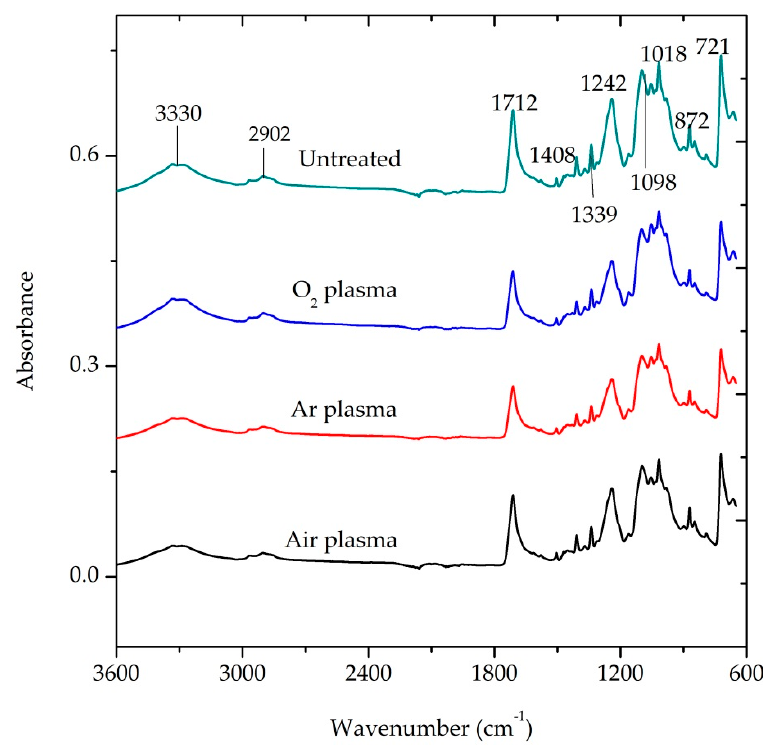
Figure 10. ATR-FTIR spectra of plasma treated and untreated P / C blend fabric (plasma condition: 0.3 mbar pressure, 10 min treatment time, 500 W power and 60 sccm gas flow rate).